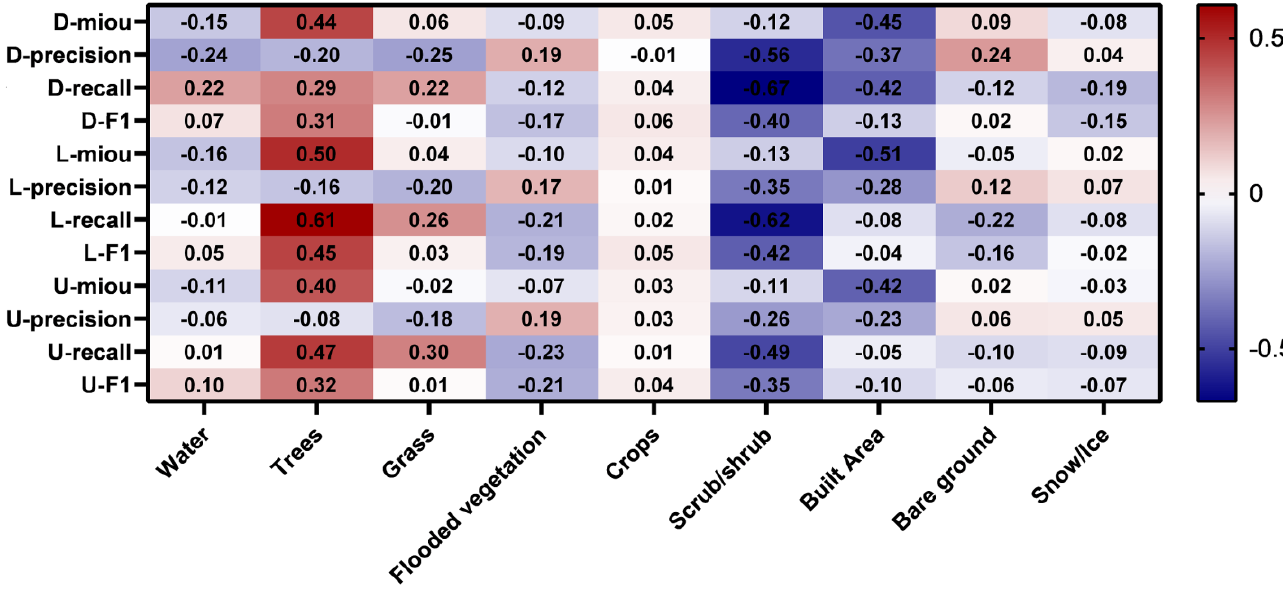
Figure 9. The PCCs between the land cover types and the road extraction performance indexes. D-, L-, and U- indicate the results obtained by D-LinkNet, LinkNet, and U-Net, respectively. L-, and U- indicate the results obtained by D-LinkNet, LinkNet, and U-Net,